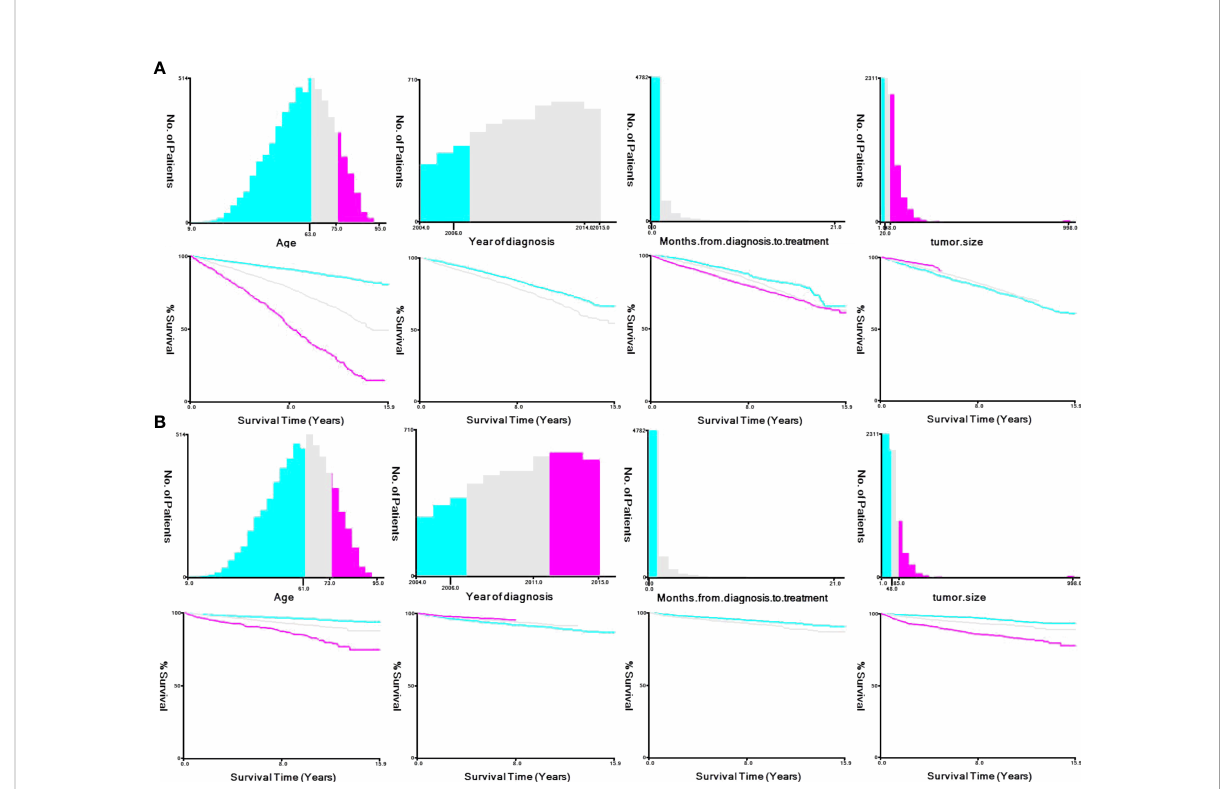
FIGURE 4 X-tile strati fi cation. (A) Optimal cutoff points for age were 63 and 75 years in OS; P value of corresponding Kaplan – Meier curve was<0.05. Optimal cutoff point of year of diagnosis were 2006 and 2014; P value of corresponding Kaplan – Meier curve was<0.05 in OS. Optimal cutoff point of month from diagnosis to treatment was 1 in OS; P value of corresponding Kaplan – Meier curve was<0.05. Optimal cutoff point of tumor size were 20 mm and 48 mm in OS; P value of corresponding Kaplan – Meier curve was<0.05. (B) Optimal cutoff points for age were 61 and 73 years in CSS; P value of corresponding Kaplan – Meier curve was<0.05. Optimal cutoff point of year of diagnosis were 2006 and 2011; P value of corresponding Kaplan – Meier curve was<0.05 in CSS. Optimal cutoff point of month from diagnosis to treatment was 1 in CSS; P value of corresponding Kaplan – Meier curve was<0.05. Optimal cutoff point of tumor size were 48 mm and 85 mm in CSS; P value of corresponding Kaplan – Meier curve